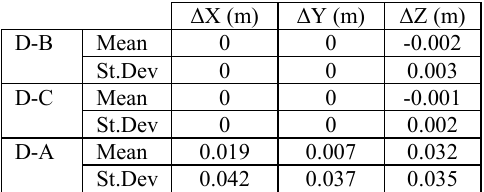
Table 5. Deviations between 3D camera coordinates estimated with GCP configurations A, B and C with respect to configuration D (used as ground reference) The values reported in